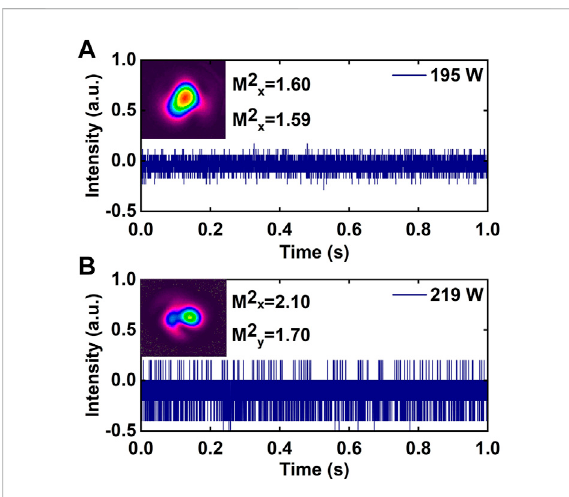
FIGURE 4 Temporal trace and the beam quality of the output laser, measured at (A) 195 W; (B) 219